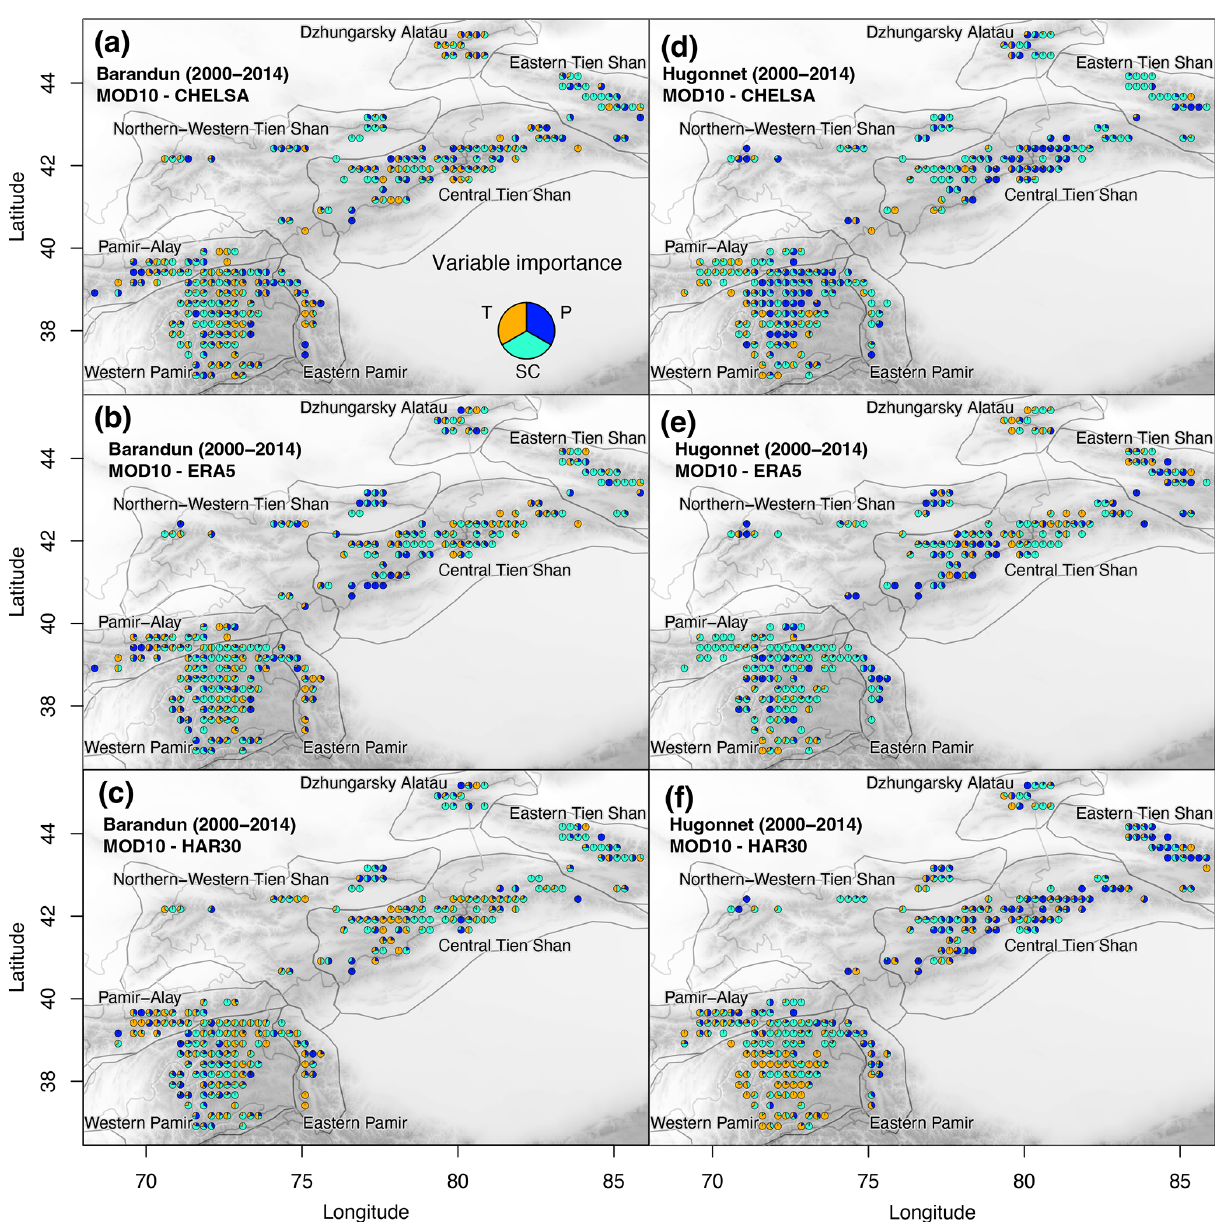
Figure 9. Importance of meteorological variables for the temporal analysis between annual mass balance estimates from (a–c) Barandun et al. (2021a) and (d–f) Hugonnet et al. (2021) and two meteorological variables from the different reanalysis datasets and